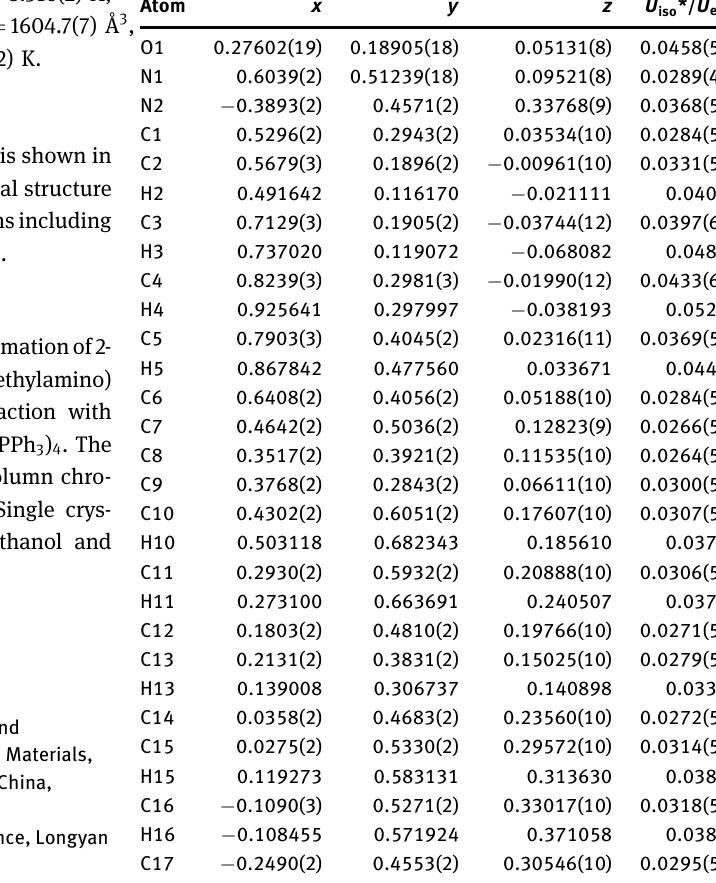
Table 2: Fractional atomic coordinates and isotropic or equivalent isotropic displacement parameters (Å 2